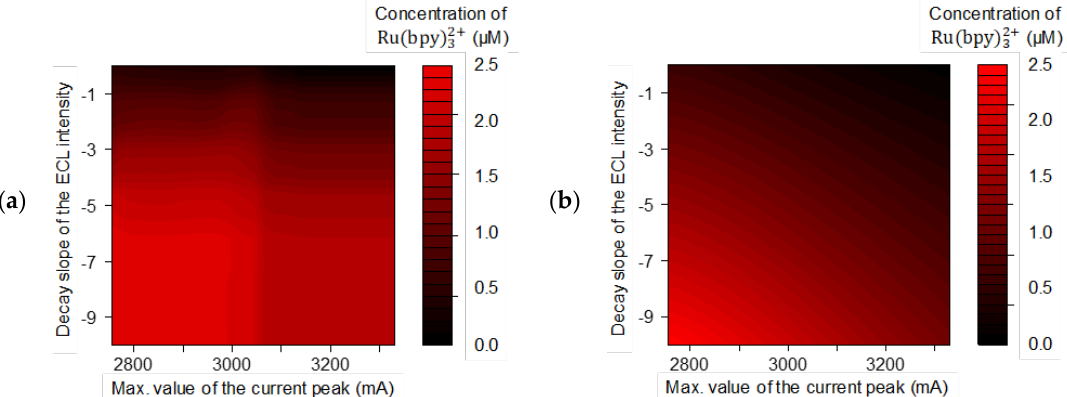
Figure 8. Contour plot generated by ( a ) random forest and ( b ) feedforward neural network at a fixed C mind .